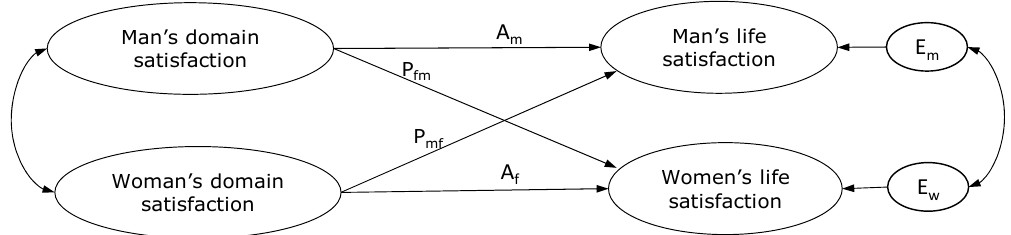
Figure 1. Basic actor–partner interdependence model of life domain satisfaction and life satisfaction. A m : Actor e ff ect of a man’s domain satisfactions on his own life satisfaction; A f : actor e ff ect of a